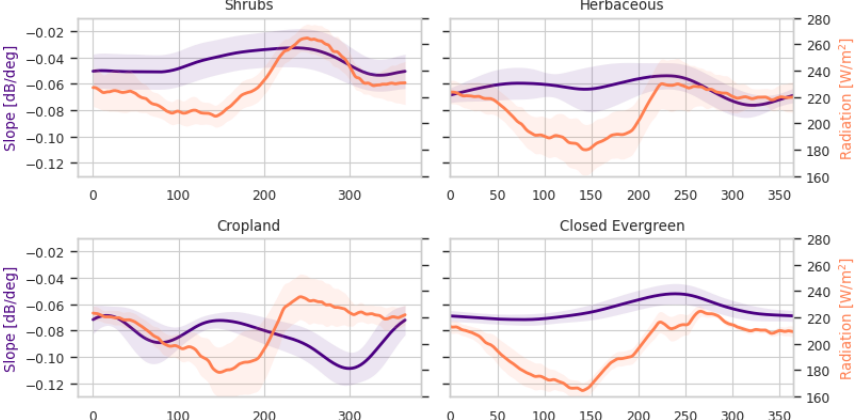
Figure 10. Seasonal cycle of the slope and radiation per land cover class in the Cerrado region. Only ASCAT pixels in which the fraction of the dominant land cover type exceeds 80% are